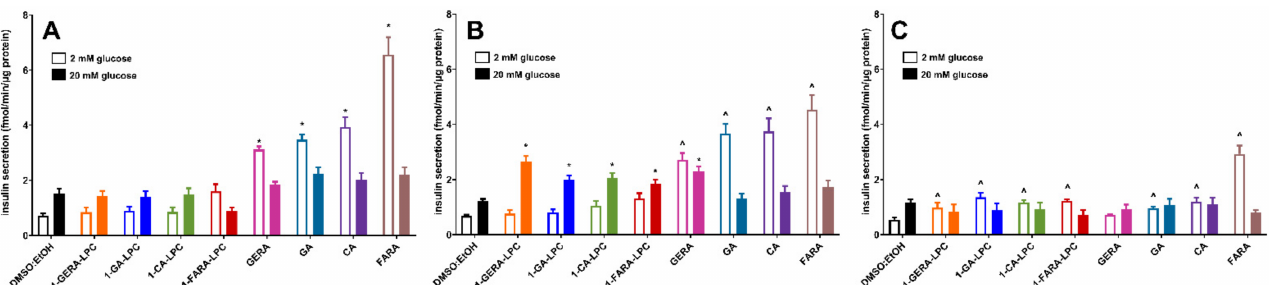
Figure 3. GSIS in MIN6 cells stimulated with 1-GERA-LPC, 1-GA-LPC, 1-CA-LPC, 1-FARA-LPC, and corresponding acids (GERA, GA, CA, FARA) at 5, 10 and 25 µ M concentrations ( A – C , respectively) versus compound solvent control (DMSO:EtOH). Results are presented as means ± SEM from 6 independent experiments, 4 biological replicates each. Secreted insulin was quantified at 2 mM glucose (open bars) and 20 mM glucose conditions (closed bars). p < 0.05 for secretion was significantly different from 2 mM glucose control (ˆ) or 20 mM glucose control